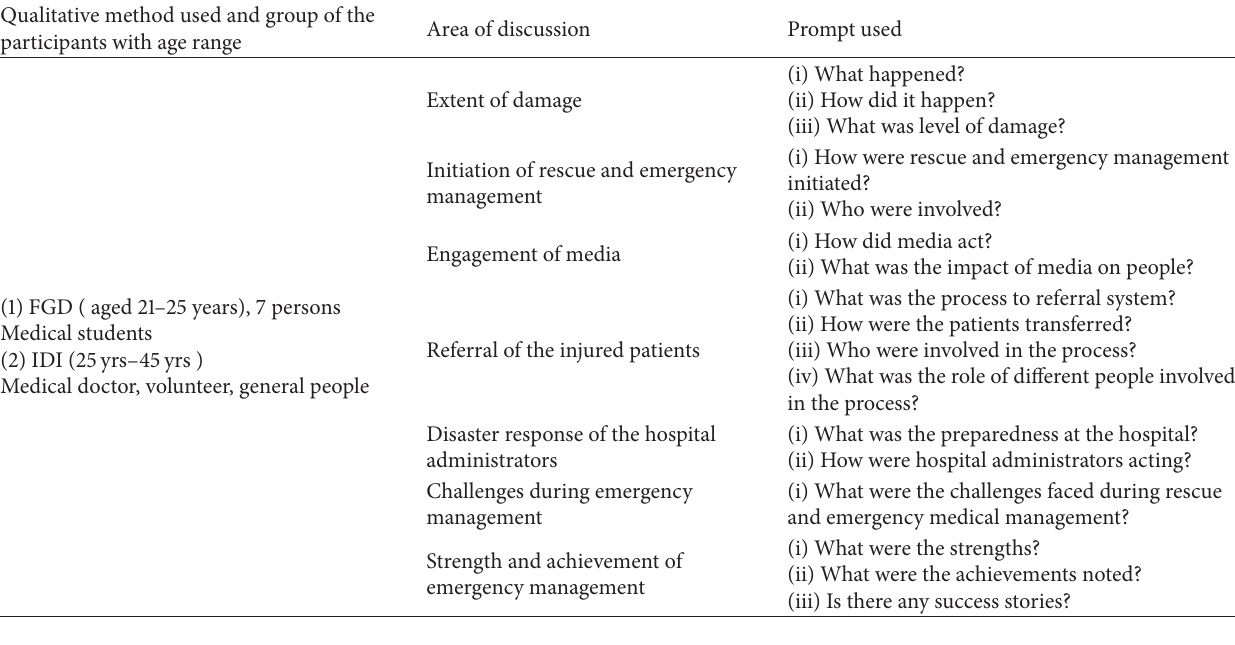
Qualitative method used and group of the